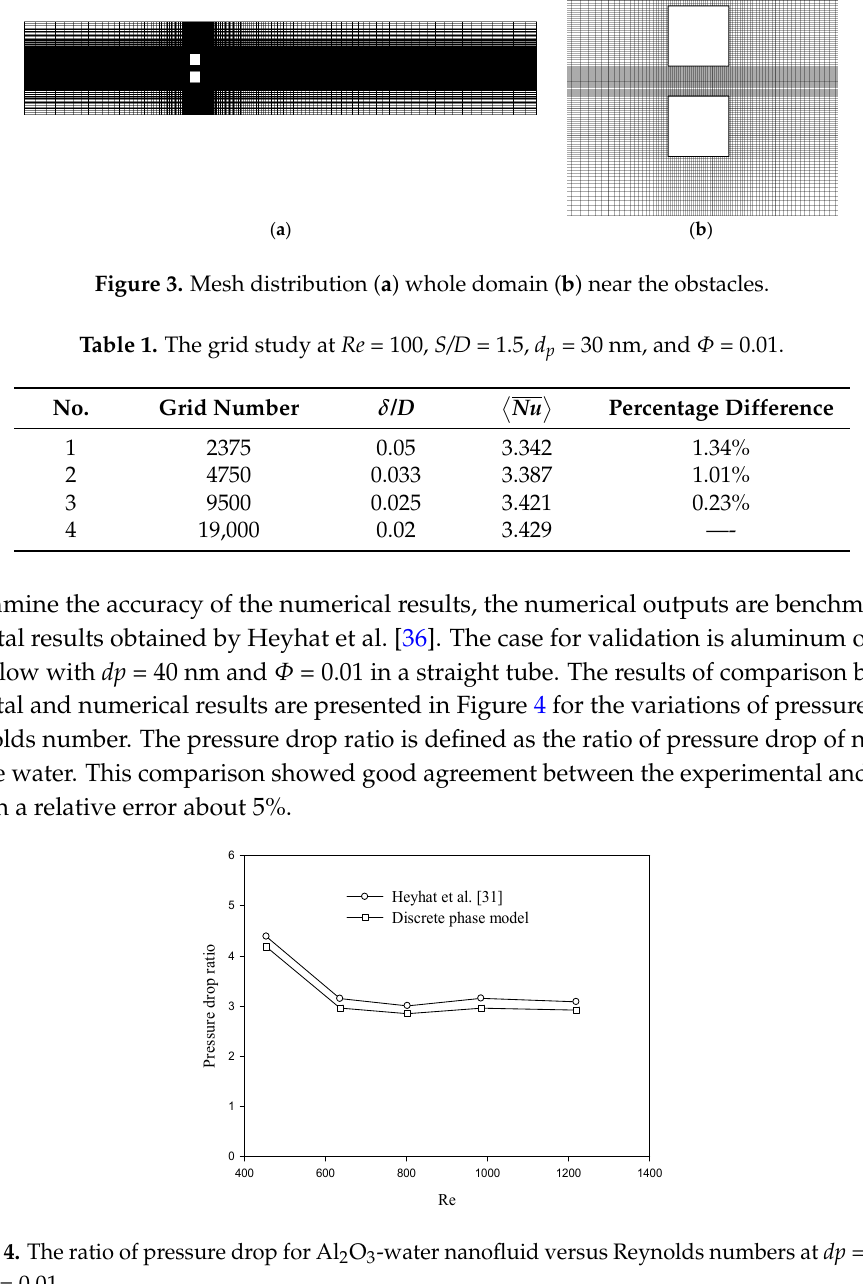
Figure 2. Procedure of numerical solution in Fluent for this problem.